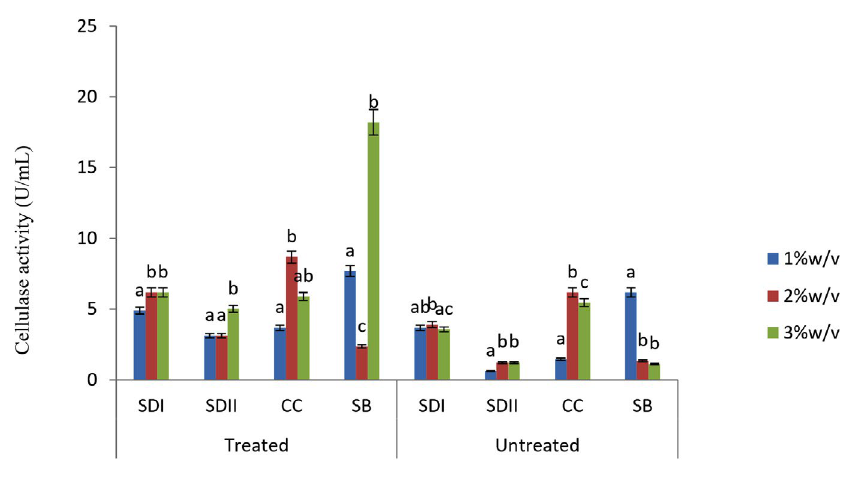
Fig. 4. Degradation ability of the isolates TRC on Lignocellulose Substrates